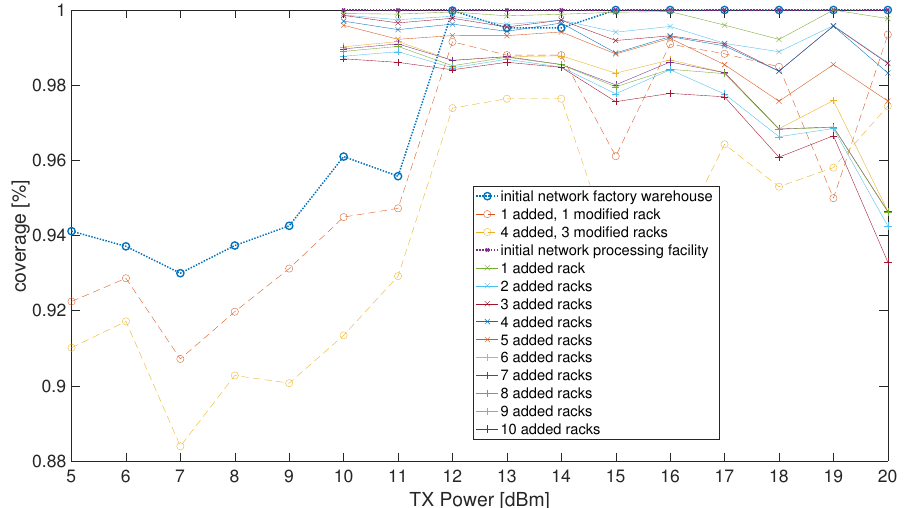
Figure 10. Network coverage as a function of the maximum transmit power of the access